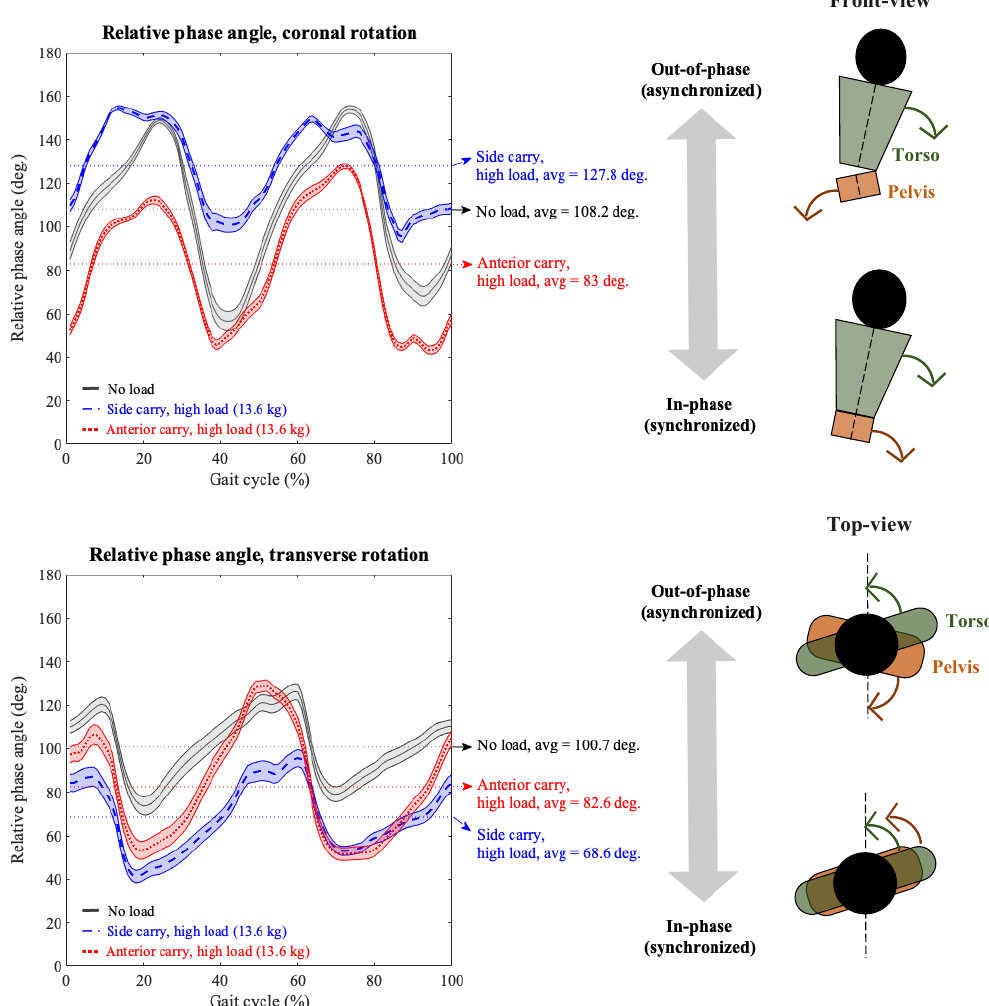
Figure 2. Mean ( ± standard error) thoracic-pelvic relative phase angle in the coronal plane ( top panel) and transverse plane ( bottom panel) obtained from the average gait cycle data of n = 9 participants and normalized to individual gait cycle duration. The figure compares two-handed side carry and two-handed anterior carry (colored blue and red, respectively) in high load level at 13.6 kg with respect to the no-load (empty-handed; grey). Higher values of mean relative phase angles indicate out-of-phase or less synchronized rotational movements between the torso and